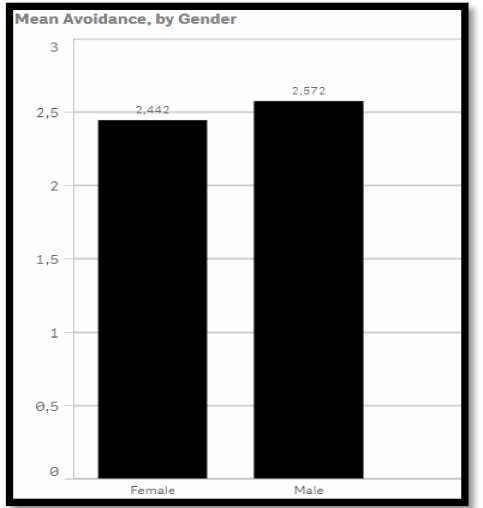
Figure 5. Avoidance, by Gender. Source: data study